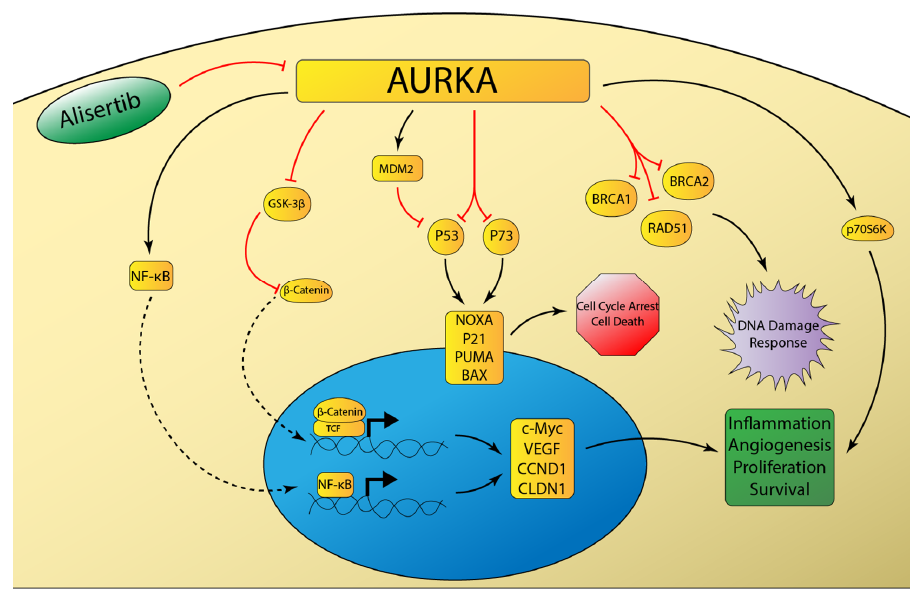
Figure 2. Schematic representation of aurora kinase A (AURKA) signaling networks involved in cancer. AURKA overexpression inhibits the DNA damage response and attenuates DNA-damage induced cell cycle arrest and apoptosis through inhibition of p53 family member proteins [129]. AURKA induces inflammatory signaling mediated by NF-κB [133], as well as pro-survival signaling mediated by beta-catenin [132] and p70S6K [135].